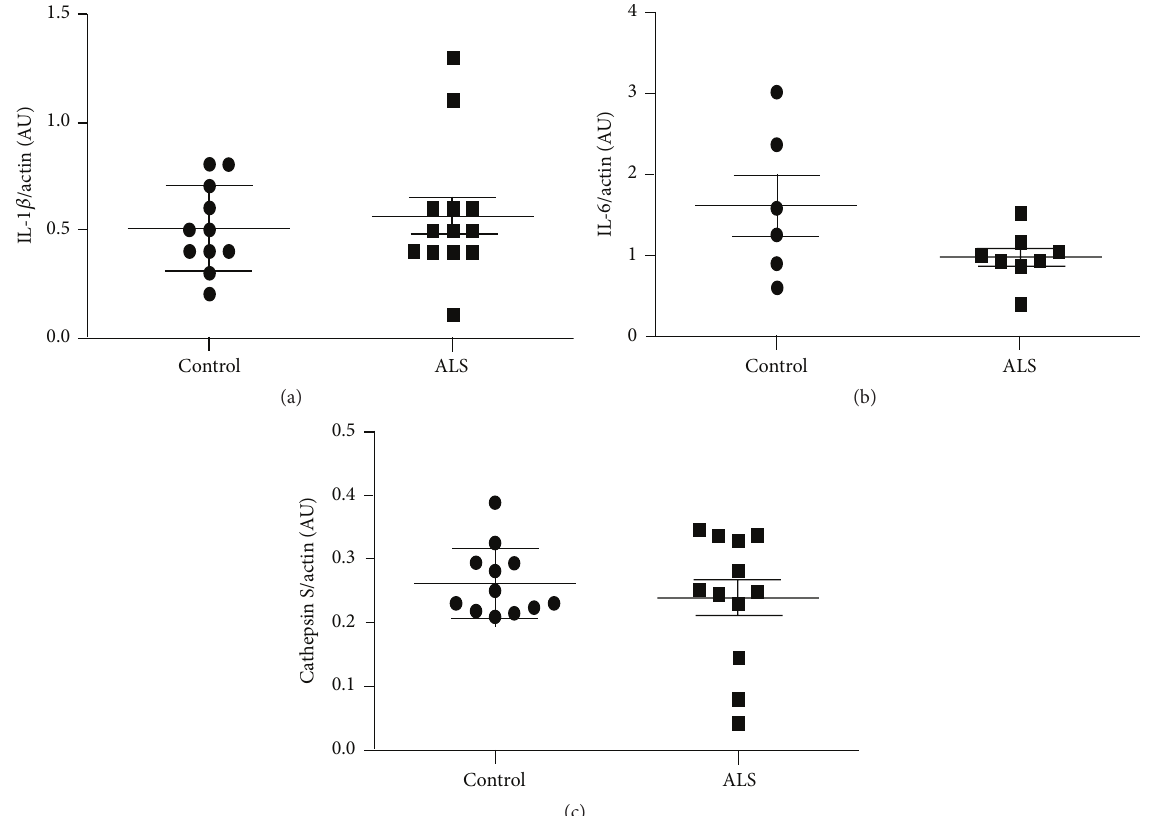
Figure 1: Quantification of western blotting of IL1 𝛽 (a), IL-6 (b), and cathepsin s (c) in lumbar spinal cord shows no significant differences in control and ALS cases. 𝛽 -actin levels were used as loading control. Densitometric quantifications are expressed as mean values ±